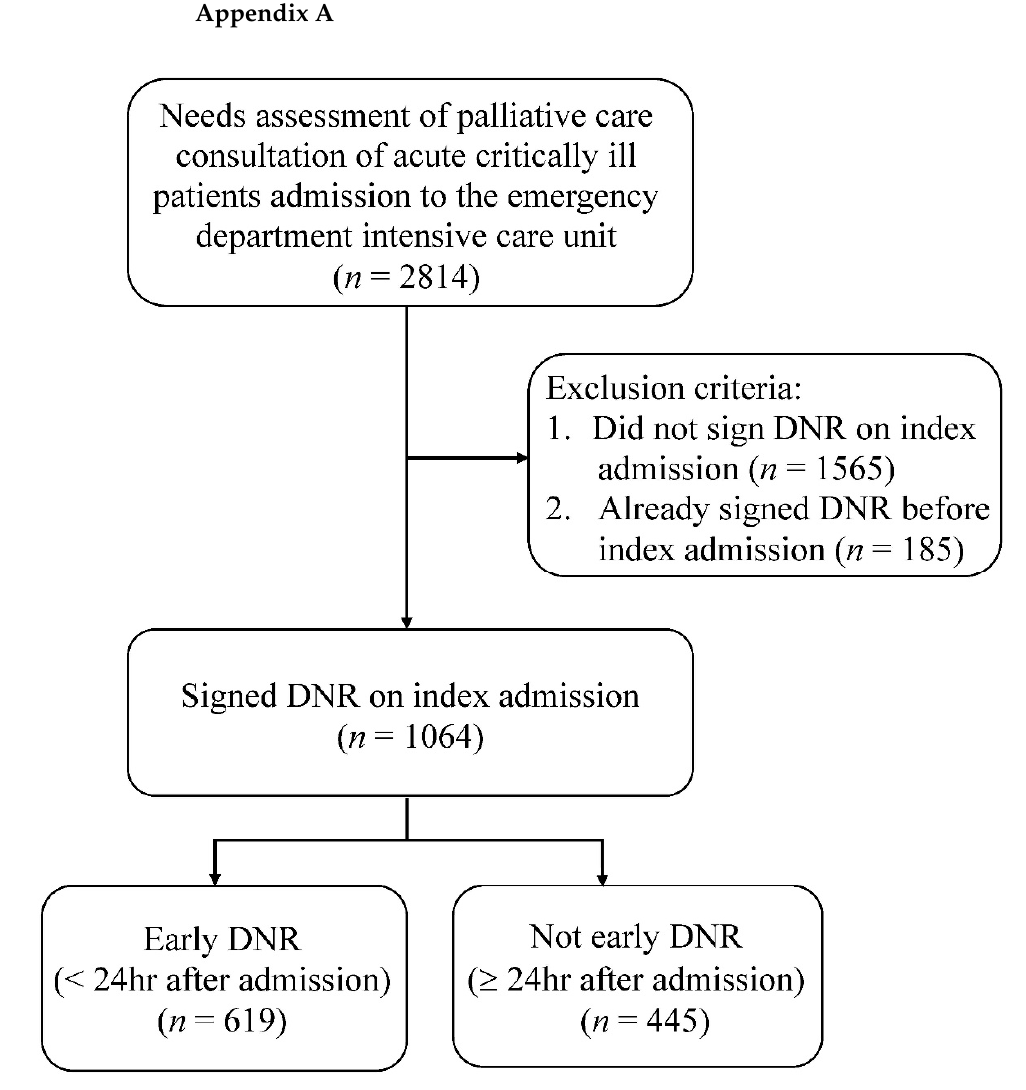
Figure A1. Flow shart on patient selection.